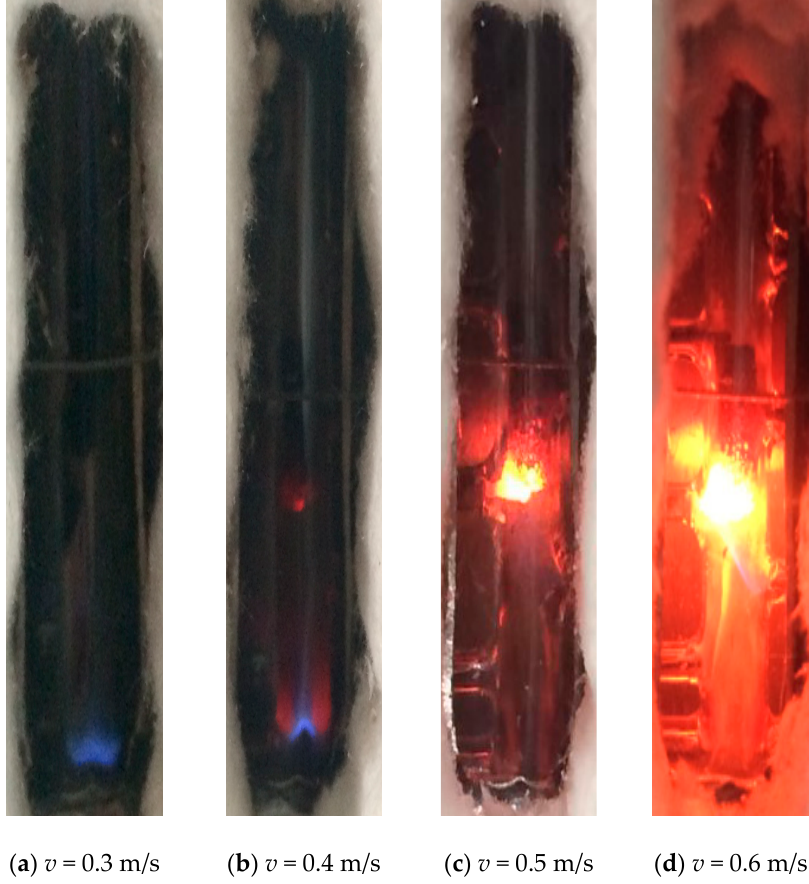
Figure 4. Photos of steady combustion flames with different velocities (front view) at Φ = 1.0: ( a ) v = 0.3 m/s; ( b ) v = 0.4 m/s; ( c ) v = 0.5 m/s; ( d ) v = 0.6 m/s.